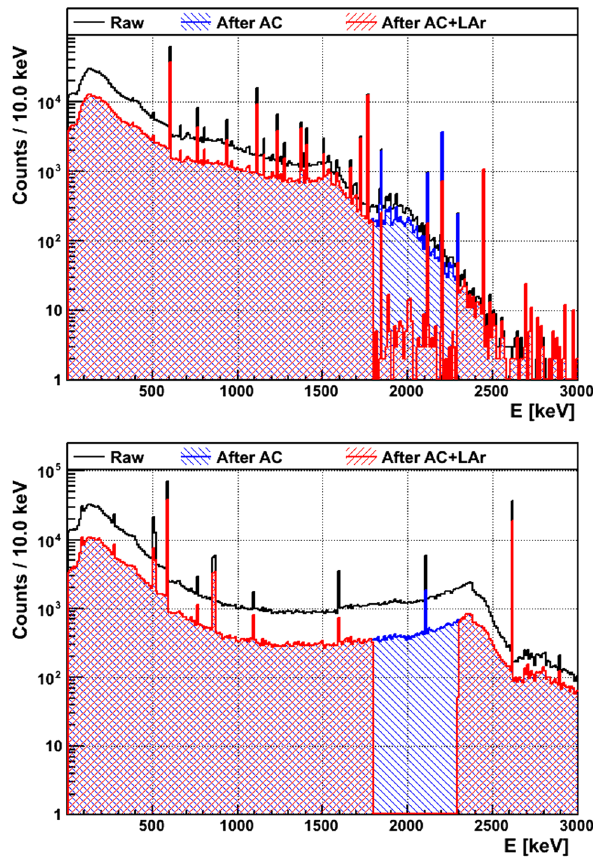
Fig. 5 Simulated energy spectra of germanium detector taken with 214 Bi (top) and 208 Tl (bottom) sources. The simulated spectra before cutsareshowninblack,afterthedetectoranti-coincidence(AC)inblue, and after applying the LAr scintillation veto cut in red [18]. Simulation of the anti-coincidence spectrum was only performed near Q ββ , to save computation time